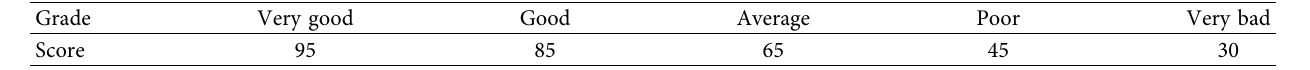
Table 9: Relationship between scores and safety grades.